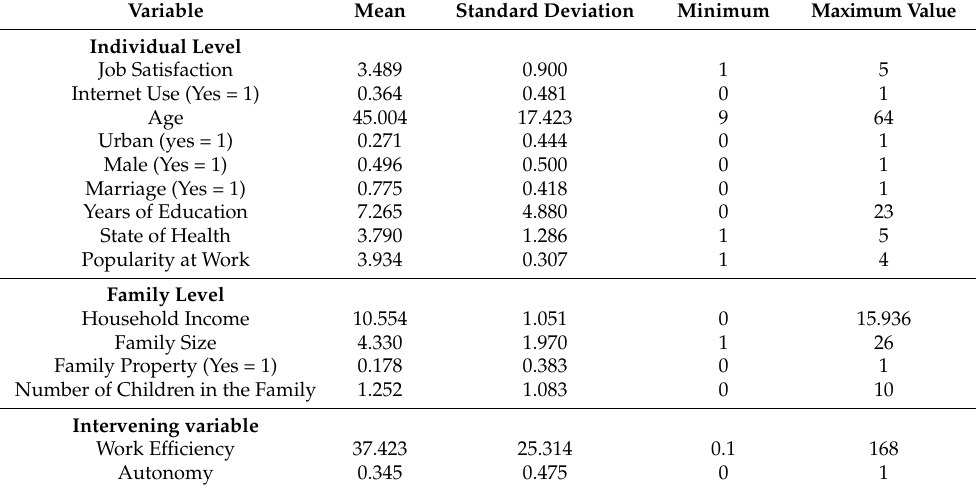
Table 1. Descriptive